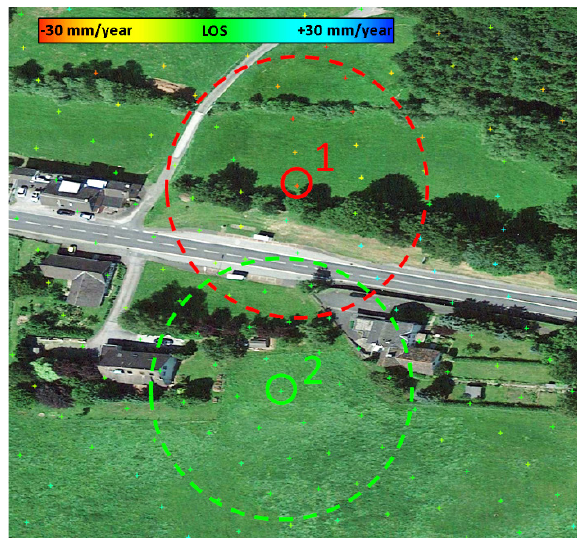
Figure 11. SBAS deformation map (Hattingen, Germany, 2015). Sinking point 1 (-29 mm/year) at venue of water pipe break. Neighbour 1 of diameter 50 m: average, -6 mm/year; STD, 7 mm/year. Stable point 2 (-1 mm/year) at grass. Neighbour 2 of diameter 50 m: average, -2 mm/year; STD, 3 mm/year.